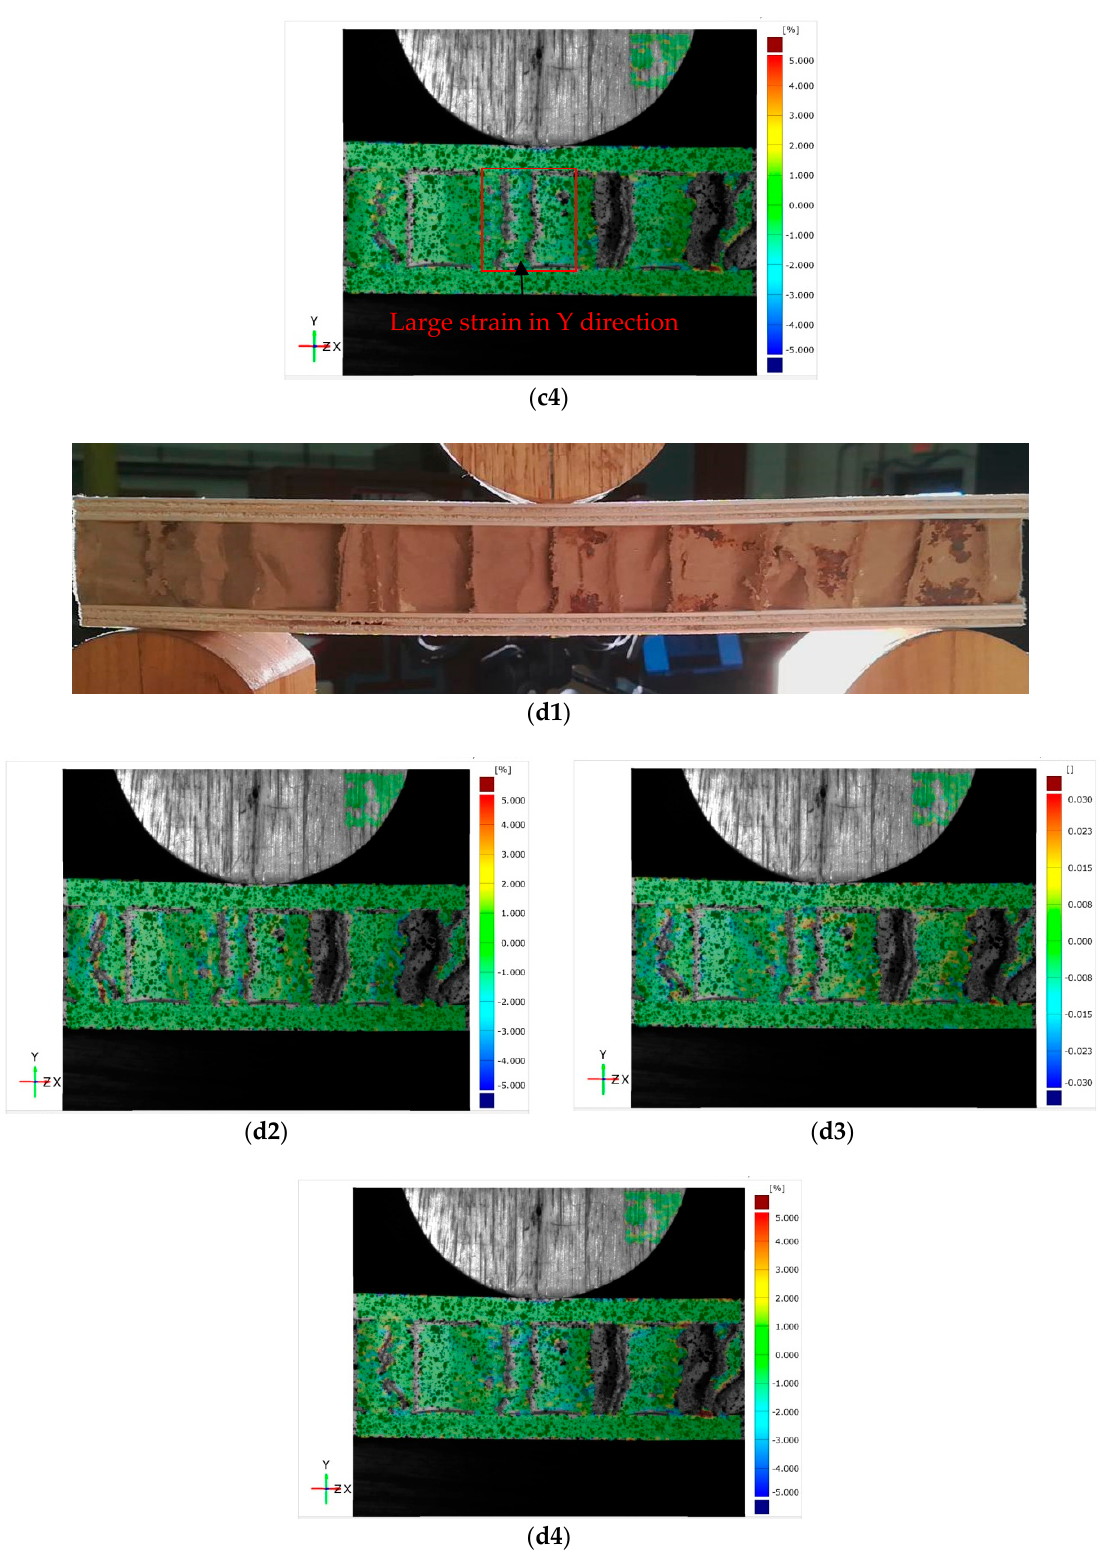
Figure 4. Photographs and strain distribution of core shear failure process of wooden sandwich beam with Taiji honeycomb core: a1 for photograph, a2 for (cid:101) x , a3 for γ xy and a4 for ε y under unloaded condition; b1 for photograph, b2 for (cid:101) x , b3 for γ xy and b4 for ε y under buckling of inclined cell wall; c1 for photograph, c2 for (cid:101) x , c3 for γ xy and c4 for ε y under buckling of whole cell wall; d1 for photograph, d2 for (cid:101) x , d3 for γ xy and d4 for ε y under post-buckling stage.